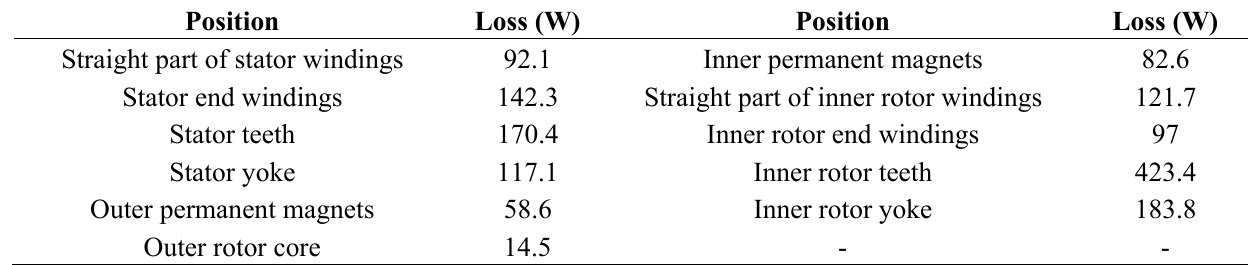
Table 3. Losses on rated load condition.